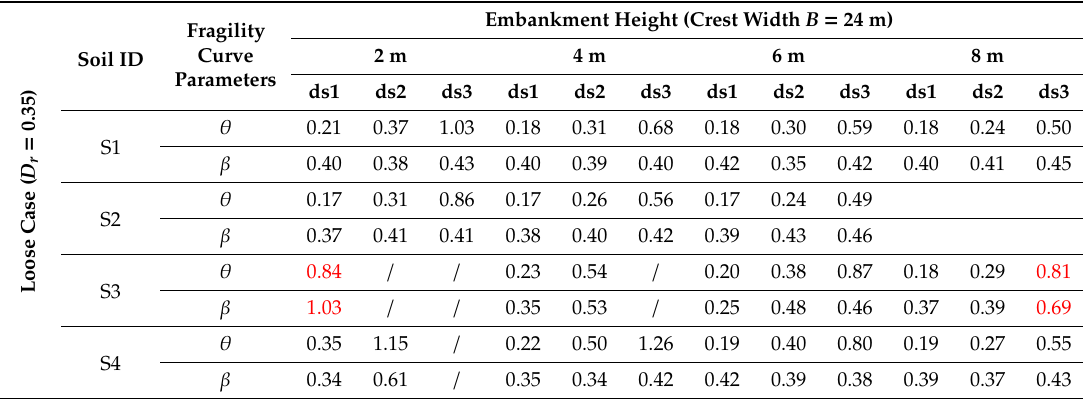
Table 6. FC parameters for di ff erent embankment heights (loose soil, PGA, road criteria).